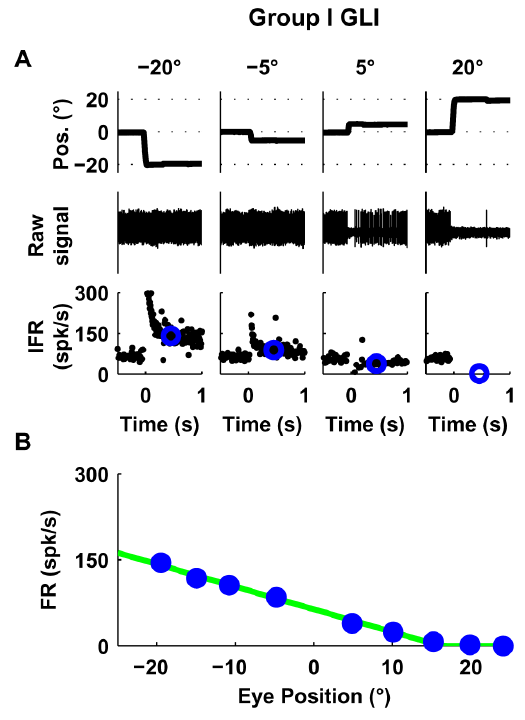
Figure 3. Response of one GLI with a linear response profile (Group I). ( A ) The upper row shows horizontal eye position, the middle raw spike data, and the bottom row instantaneous firing rate (IFR). Blue circles in the lower row represent the average firing rate following each saccade (200–700 ms). ( B ) Relationship between average firing rate and eye position using data from trials like those shown in A. The response of this example GLI was closely fit by a linear function